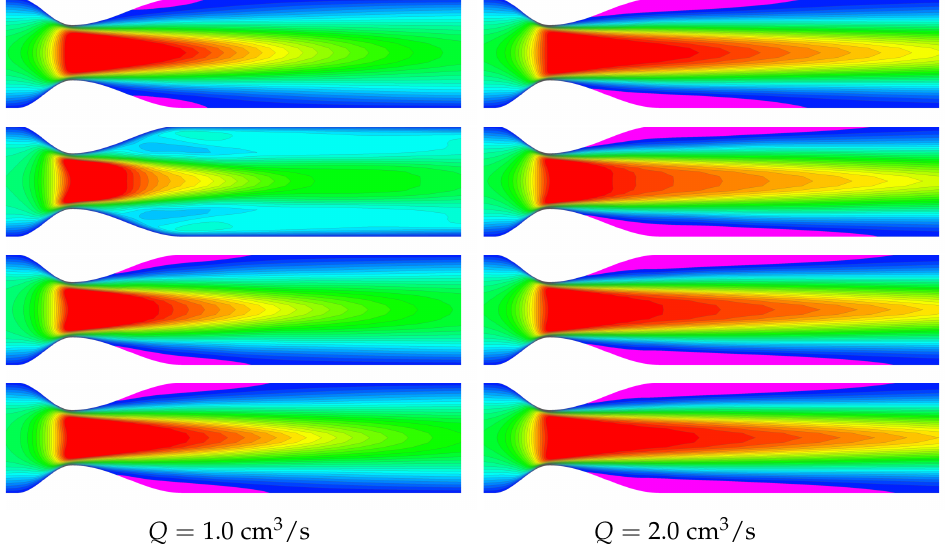
Q = 1.0 cm 3 /s Q = 2.0 cm 3 /s Figure 17. Axial velocity and recirculating flow—GOB (top figure) and Johnson–Segalman models for a = − 0.9, a = − 0.8, a = − 0.7 (from the top). Reversal flow is marked by purple